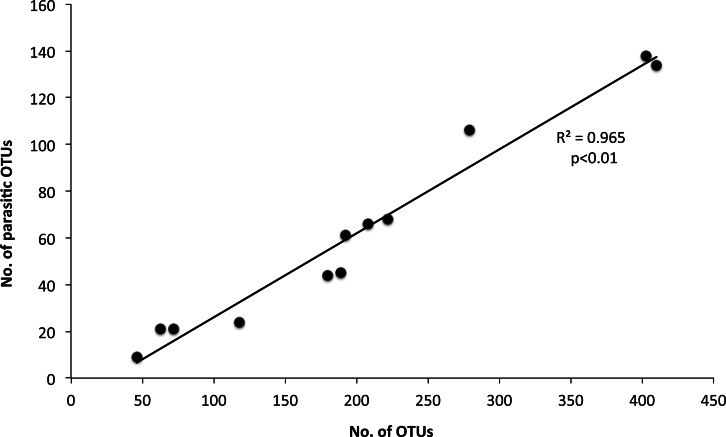
Relationship between the number of total eukaryotic and parasitic operational taxonomic units (OTUs) in the control and test tanks in every sampling point.The determination coefficient R2 and the p value of the regression are also indicated.